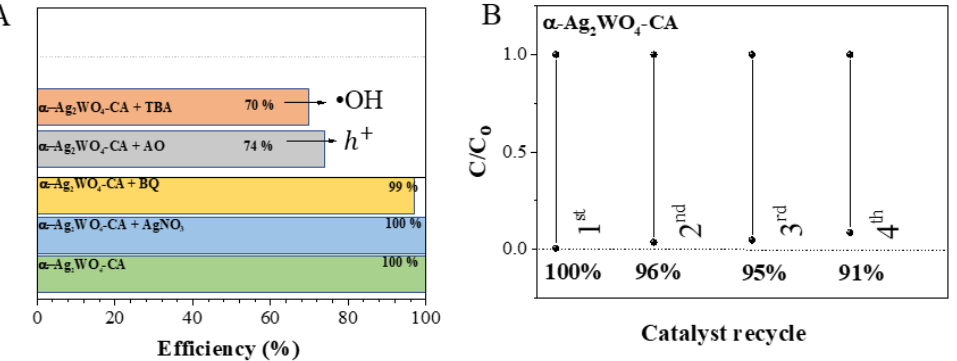
Figure 7. Photocatalytic RhB degradation profiles using α -Ag 2 WO 4 -CA in the presence of different scavengers ( A ) and reuse of the α -Ag 2 WO 4 -CA catalyst after catalytic cycles ( B ). Reuse experiments using 2 mg/mL were performed to evaluate the photocatalytic stability of the α -Ag 2 WO 4 -CA. The results are shown in Figure 7B, where it is possible to observe that the sample decreases in photocatalytic activity at each cycle, decomposing 91% of the dye in the fourth photocatalytic cycle, thus demonstrating that the material has stability. In Figure S9, the loss of mass of the α -Ag 2 WO 4 -CA along the catalytic cycles is presented. An analysis of the results reveals that a low decrease in photocatalytic efficiency can be associated with the loss of mass after the fourth cycle. fourth cycle was performed. In Figure 8, the XRDs before and after reuse are presented. are similar.